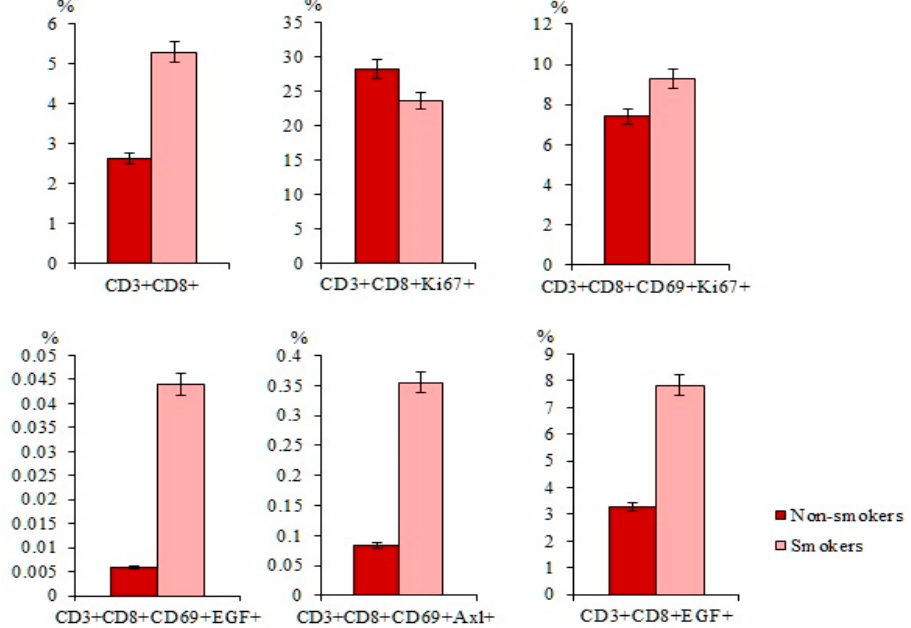
Figure 6. Content of CD3 + CD8 + , CD3 + CD8 + Ki67 + , CD3 + CD8 + CD69 + , CD3 + CD8 + CD69 + Ki67 + , CD3 + CD8 + CD69 + EGF + , CD3 + CD8 + CD69 + Axl + , and CD3 + CD8 + EGF + isolated from the blood of non-smoking and smoking patients with SCLS (percentage of all labelled mononuclear cells). Cells were analyzed by flow cytometry using antibodies against CD3, CD8, CD69, EGF, Axl, and Ki67.